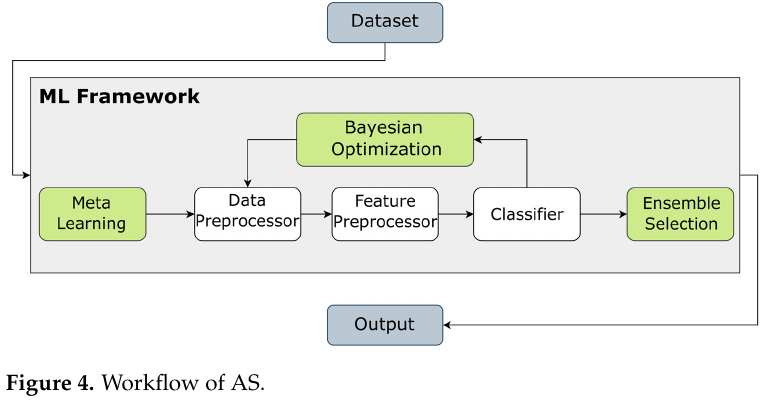
Figure 4. Work fl ow of AS. Figure 4. Workflow of AS.